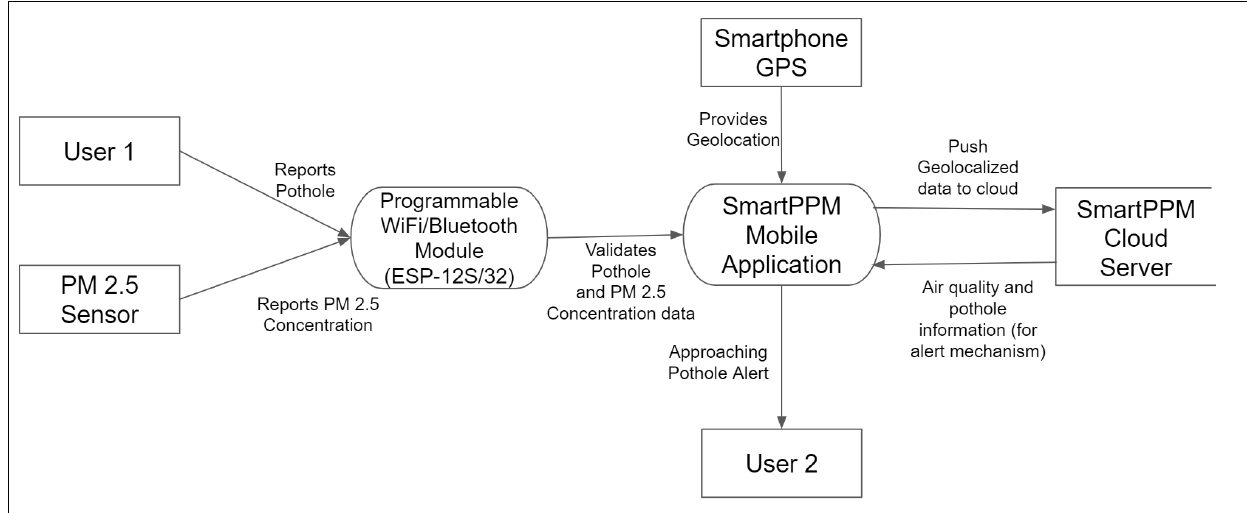
Figure 2. Data Flow diagram for SmartPPM system. Here User 1 is the person wearing the helmet whereas User 2 is the person using the mobile application to receive the approaching pothole alert. User 1 and 2 could be the same person, if wearing the SmartPPM helmet and utilize the mobile application to receive approaching pothole